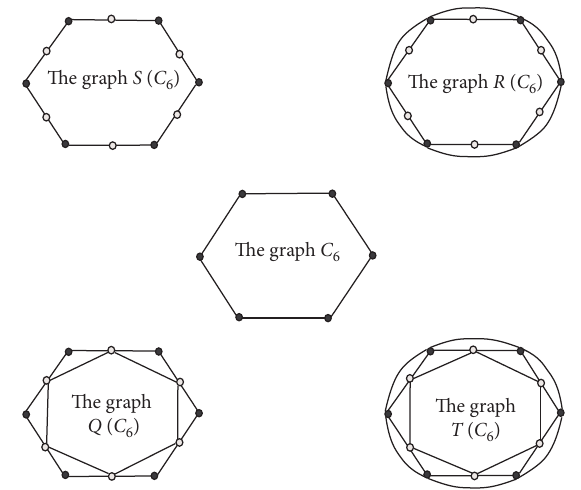
Figure 1: Base graph C